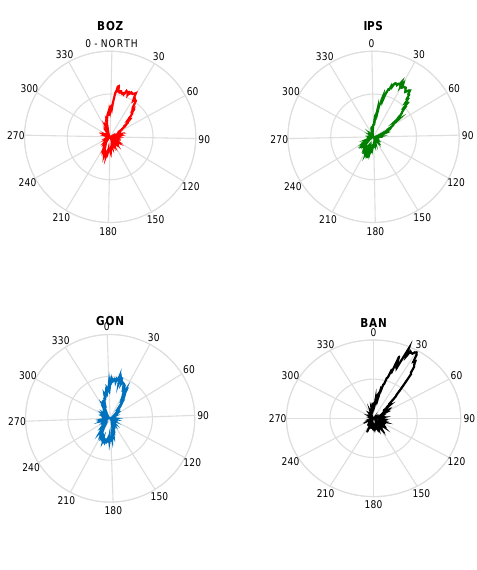
Figure 5. The frequency of the wind directions at the measurement stations for three year hourly averaged data where North is zero degree.